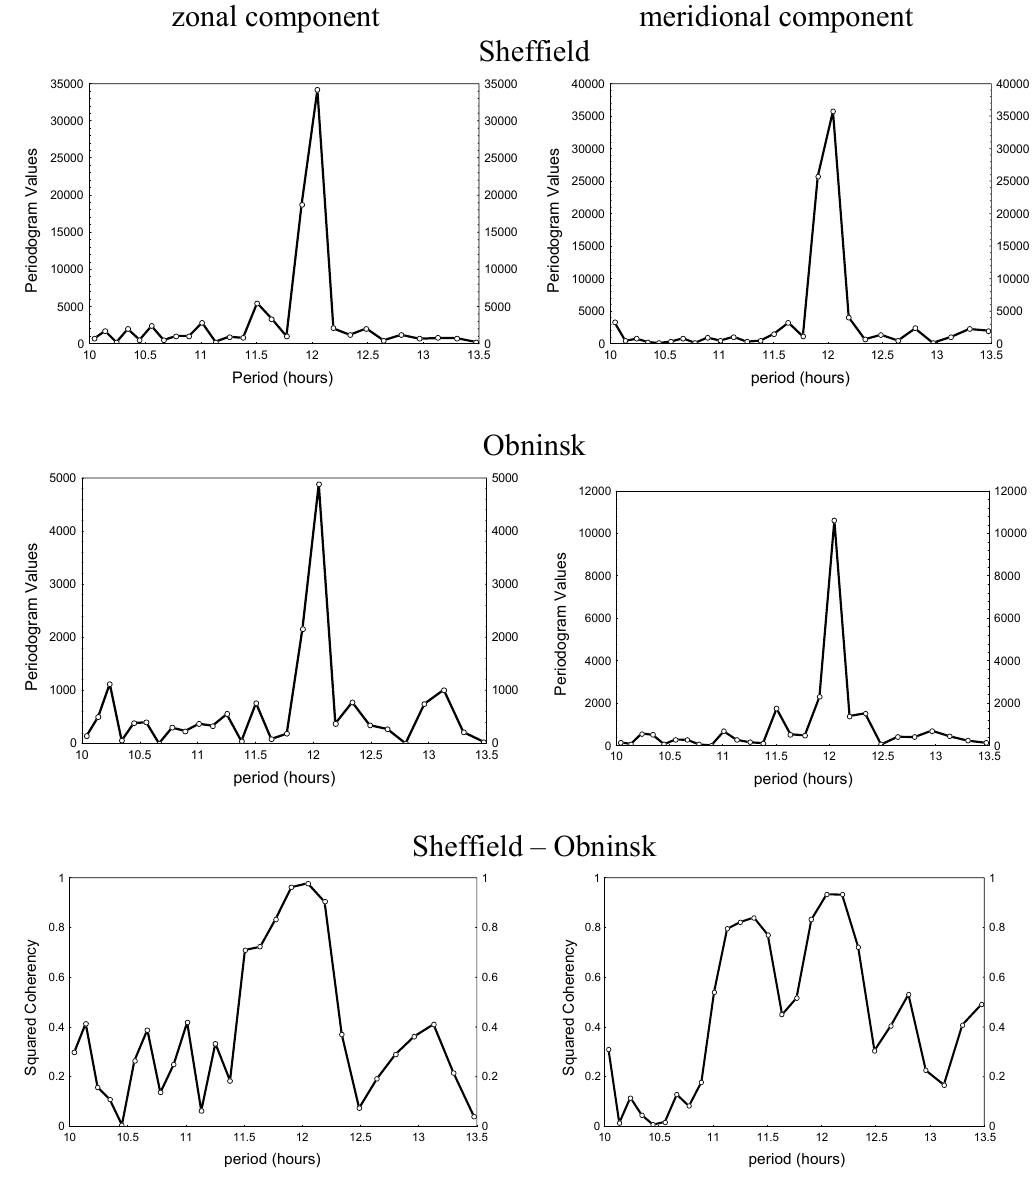
Fig. 10. Periodograms evaluated for the Obninsk and Sheffield hourly wind data. The squared coherency between the hourly winds of Obninsk and Sheffield is shown at the